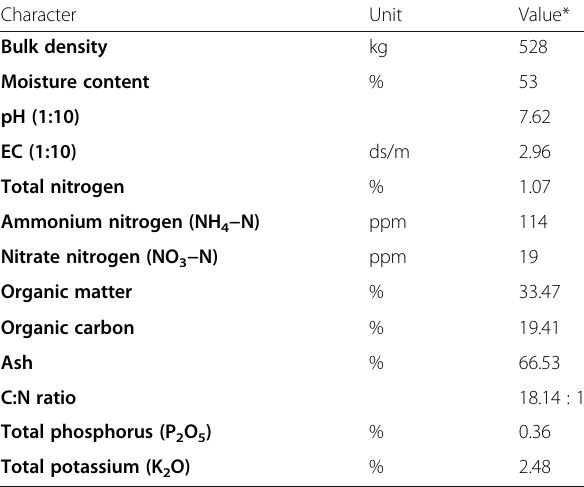
Table 2 Physico-chemical properties of compost used